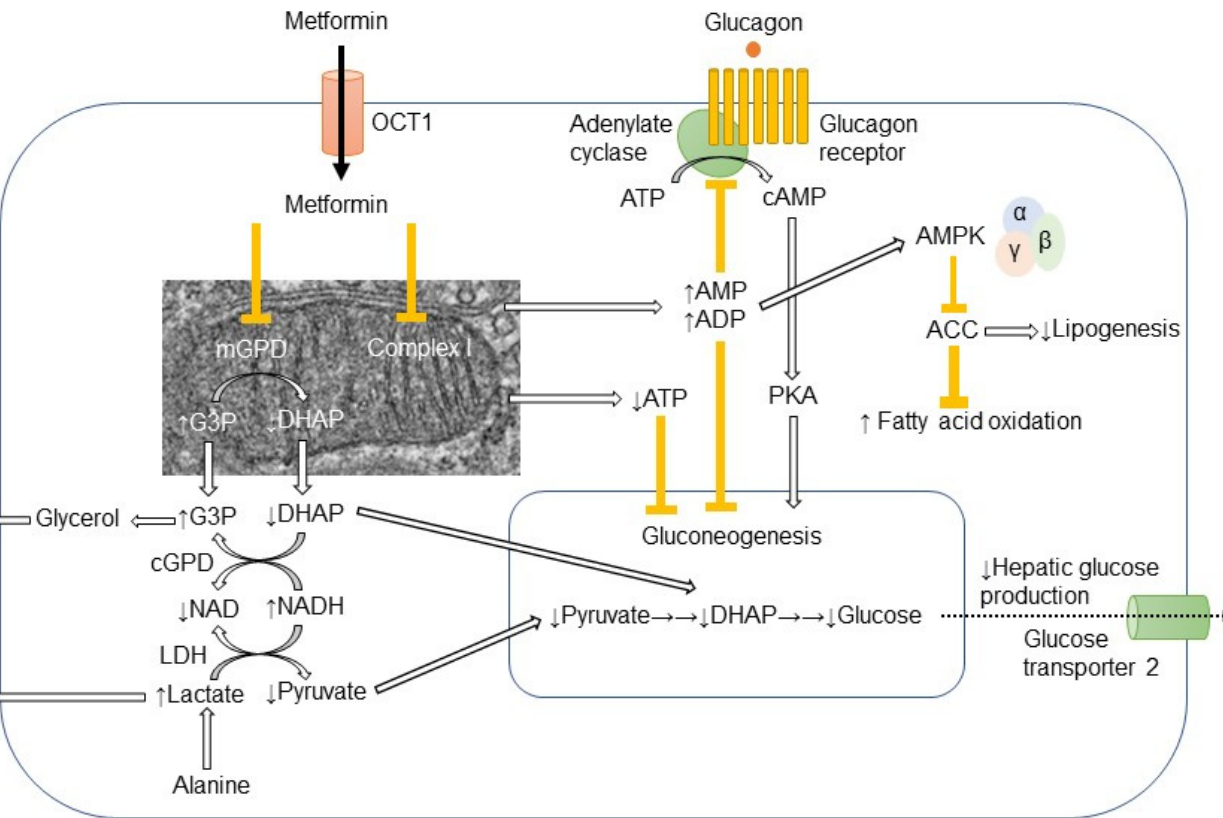
Figure 1. Action mechanism of metformin in hepatocyte.Metformin is mainly transported into hepatocyte through organic transporter 1 (OCT1) and inhibits respiratory-chain complex 1 (Complex 1). The reduction of ATP levels and increase in AMP and ADP levels result in the inhibition of gluconeogenesis. The increased AMP levels inhibit the adenylate cyclase coupled with glucagon receptor and the subsequent cAMP/protein kinase A (PKA) signaling pathway, which ultimately links to enhancement of gluconeogenesis. Metformin-induced elevation of AMP/ATP ratio also activates AMP-activated protein kinase (AMPK). Lipogenesis is inhibited and fatty acid oxidation is enhanced by the AMPK-induced inhibition of acetyl CoA carboxylase (ACC). Metformin also inhibits mitochondrial glycerophosphate dehydrogenase (mGPD) but not cytosolic GPD (cGPD). Glyceraldehyde 3-phosphate (G3P), nicotinamide adenine dinucleotide (NADH), and lactate are accumulated, while dihydroxyacetone phosphate (DHAP), NAD, and pyruvate are reduced. By the reduction of substrates for gluconeogenesis, i.e., pyruvate and DHAP, hepatic glucose production is reduced by metformin. The excess of glycerol and lactate enters into circulation.